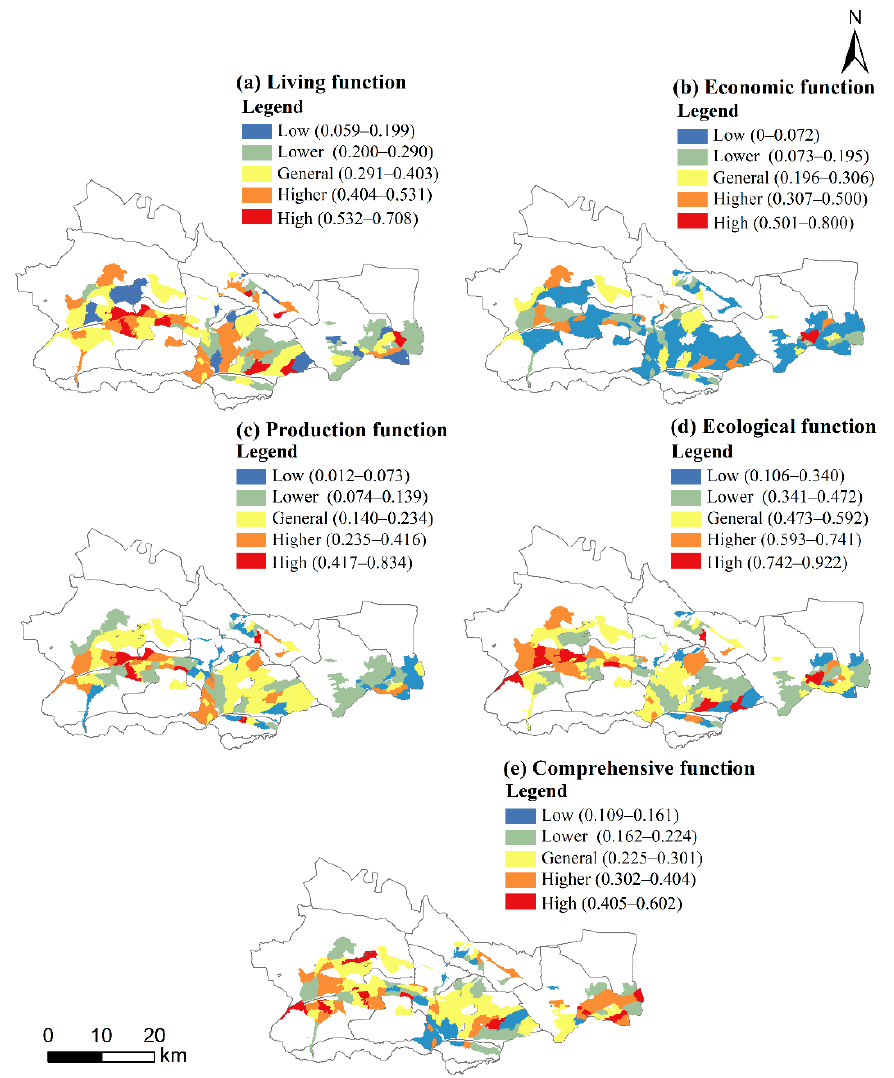
Figure 2. Multifunctional spatial differentiation in Yongchang County villages.